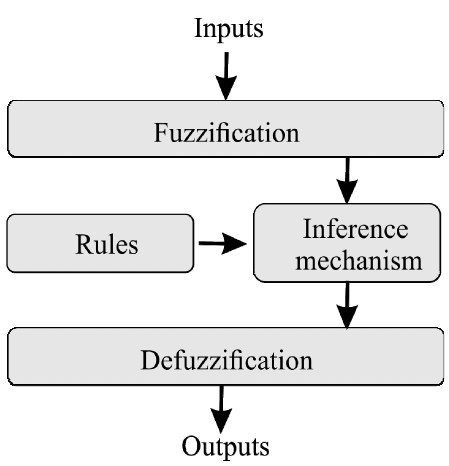
Figure 1. General diagram of a fuzzy logic (FL) system.